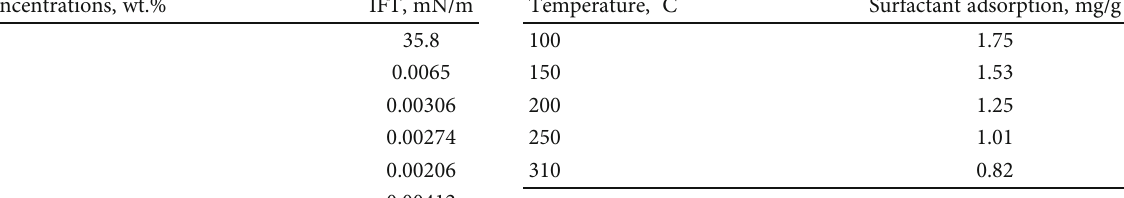
Figure 1: Static reservoir model: (a) grid top; (b) permeability; (c) porosity; (d) sector model. Table 1: E ff ects of the surfactant concentrations on IFT of heavy oil and water. Surfactant concentrations, wt.%